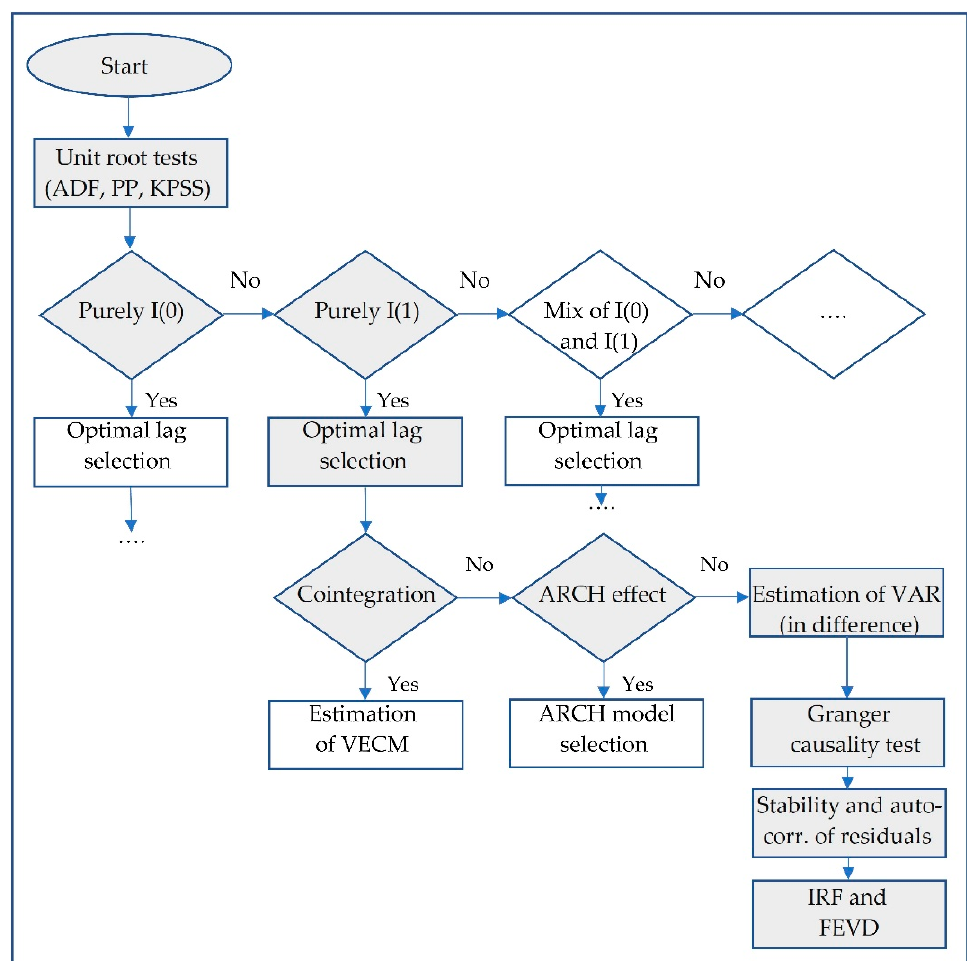
Figure 1. Conceptual framework of the applied methodology.